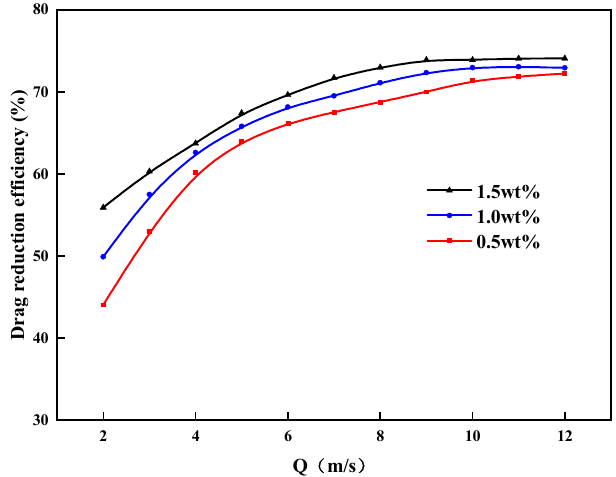
Figure 11. Plots of drag reduction efficiency versus displacement.